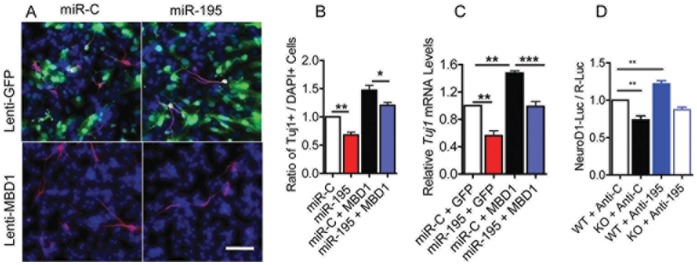
MBD1 rescues aNSC deficits associated with miR-195 overexpression.(A) Sample images showing DG-aNSCs infected with lentivirus expressing GFP as control (upper panel, GFP, green) or lentivirus expressing MBD1 (lower panel). The infected cells were then transfected with either miR-C (left panels) or miR-195 (right panels). The neuronal differentiation was assessed by using neuronal marker Tuj1 (red). DAPI, blue. (B) Overexpression of MBD1 rescued the neuronal differentiation deficits resulting from miR-195 overexpression as assessed by quantification of Tuj1+ cells over total (DAPI+) cells (Black bar v. blue bar, n = 4, p<0.05). (Same data for miR-C and miR-195 presented in Fig. 2B are used here for comparison purposes). (C) Overexpression of MBD1 rescued the neuronal differentiation deficits resulting from miR-195 overexpression as assessed by Tuj1 mRNA levels (n = 6). The color of bars in C and D represents the same conditions as B. (D) Inhibition of endogenous miR-195 using a specific inhibitor (Anti-195) rescued the neuronal differentiation deficits resulting from MBD1 deficiency as assessed by NeuroD1 promoter activities (n = 6). Data are presented as mean ± SEM; statistics were done using one-sample t-test*, p<0.05, **, p<0.01.